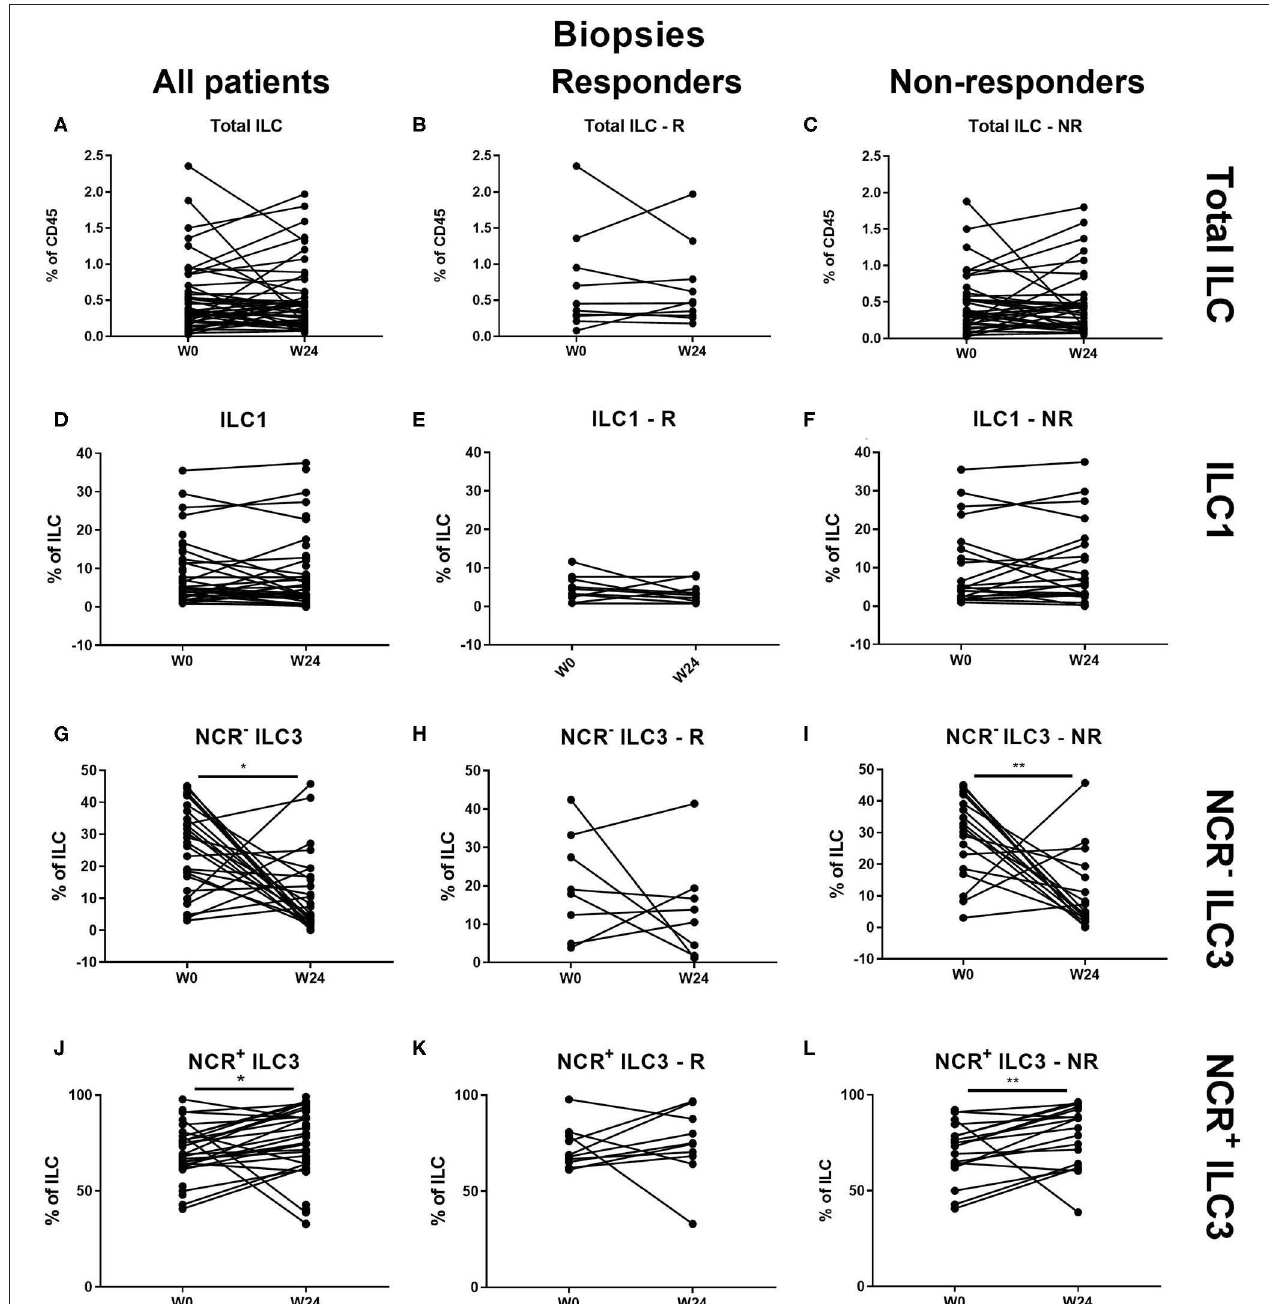
FIGURE 3 | Changes in intestinal ILC subpopulations upon ustekinumab treatment. Forty-seven patients initiating ustekinumab treatment after endoscopic evaluation were subdivided into responders (R, n = 10) and nonresponders (NR, n = 37) based on endoscopic reevaluation at week 24. Paired analysis of total ILC as proportion of CD45 + leukocytes in all patients (A) , R (B) and NR (C) . Paired analysis of ILC1 as proportion of total ILC in all patients (D) , in R (E) and in NR (F) . Paired analysis of NCR − ILC3 as proportion of total ILC in all patients (G) , in R (H) and in NR (I) . Paired analysis of NCR + ILC3 as proportion of total ILC in all patients (J) , in R (K) and in NR (L) . Wilcoxon paired-match testing (D–L) ; * p < 0.05, ** p ≤ 0.01. Responders (R), nonresponders (NR) and innate lymphoid cell (ILC).